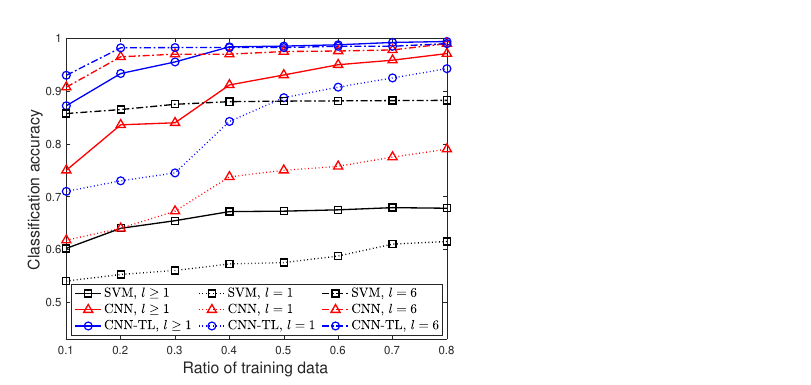
Figure 8. Classification accuracy of SVM, the CNN, and CNN–TL with different ratios of the training data, r = 0.1, . . .